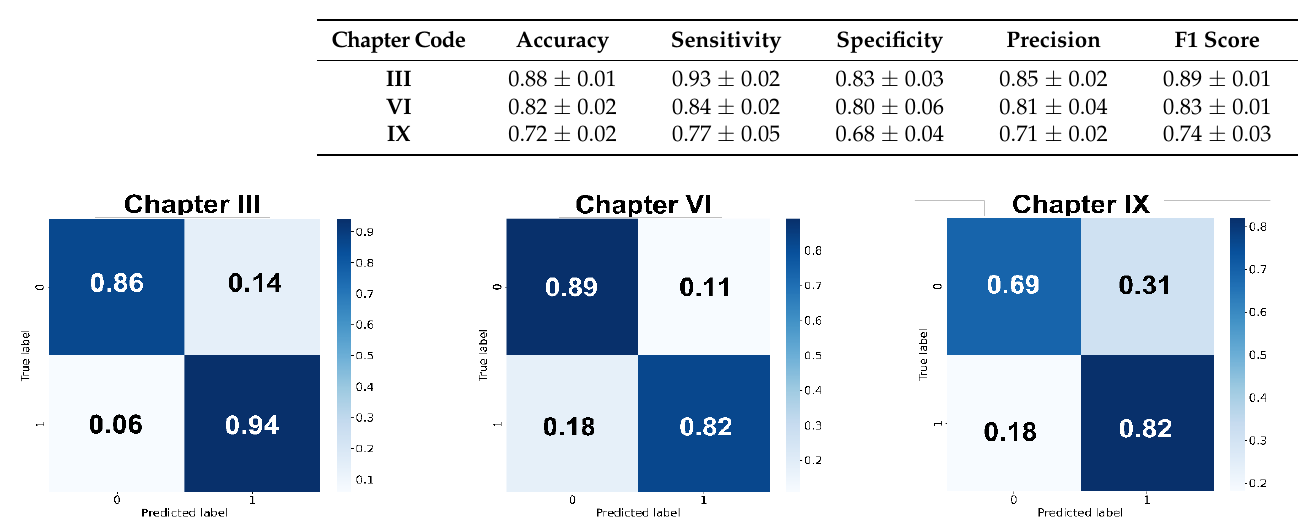
Table 2. Performance of the models on the unseen test dataset.